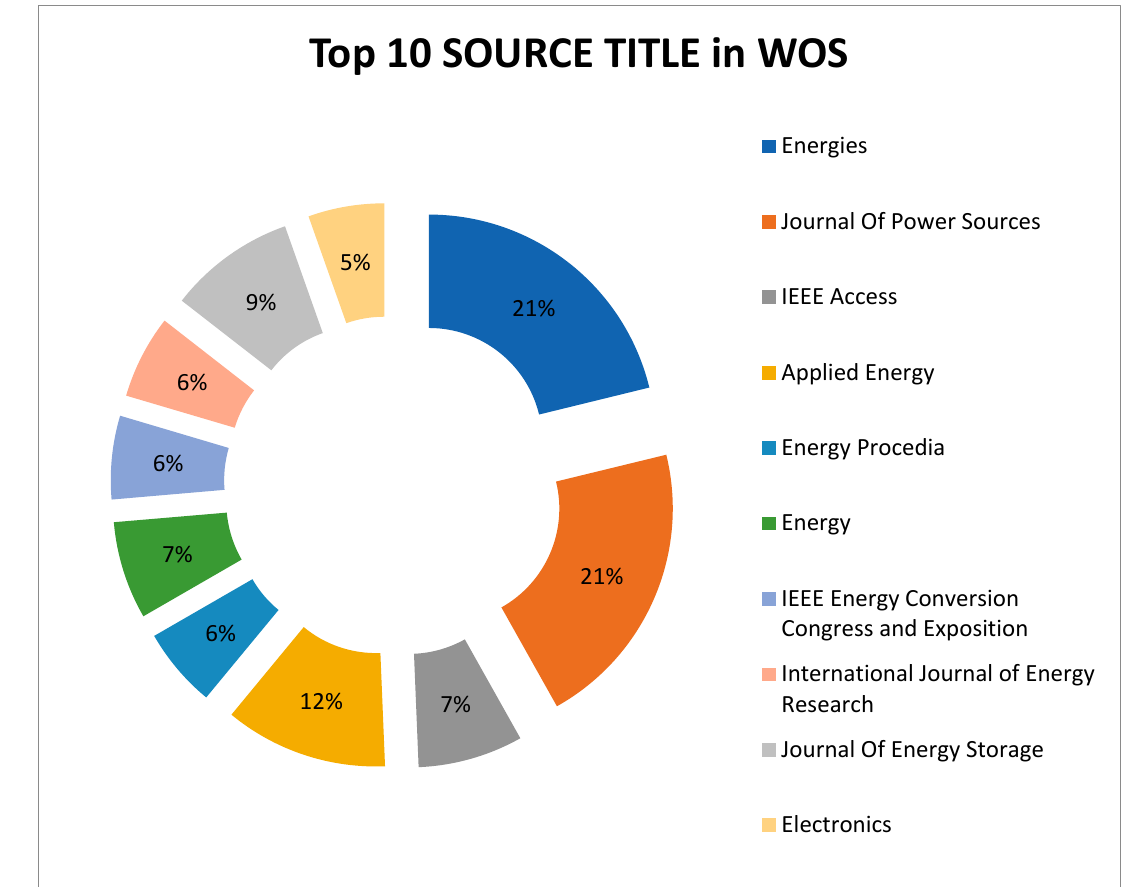
Figure 15. Top ten source titles in WOS DB.